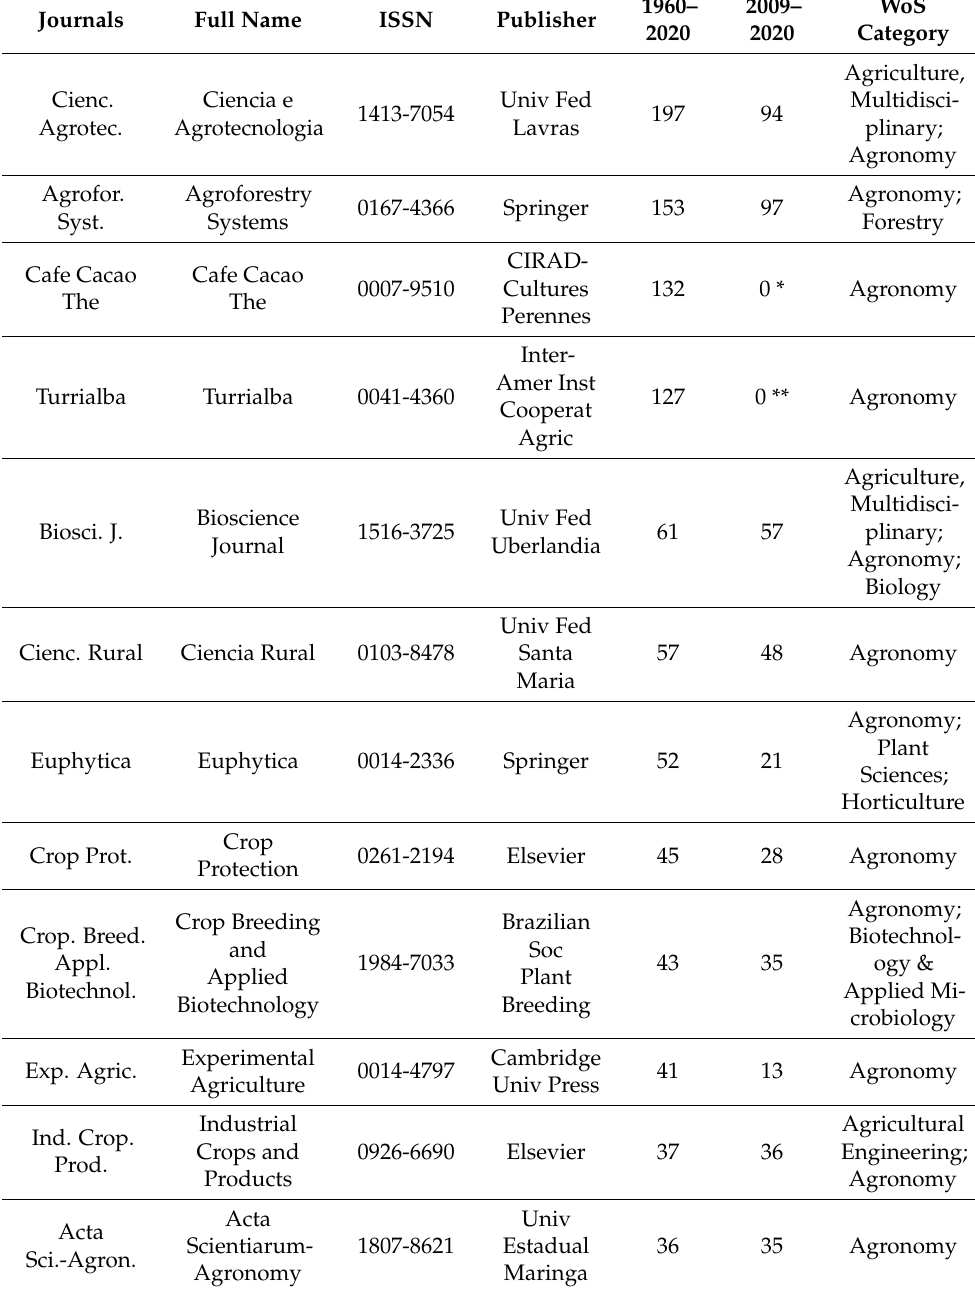
Table A1. Details of journals from major Bradford zones